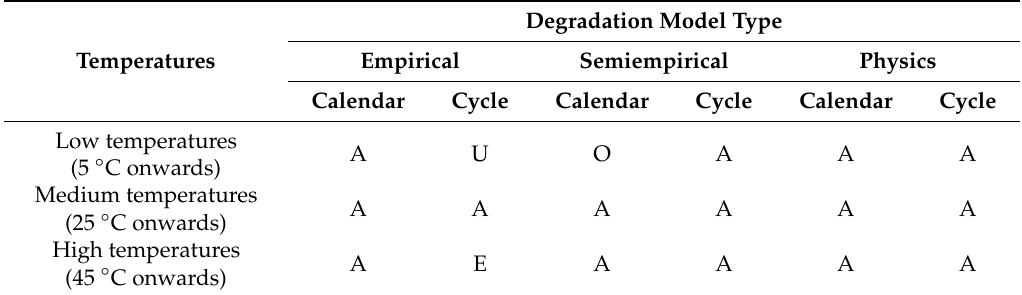
Table 2. Calendar and cycle degradation model accuracy comparisons for di ff erent temperatures.